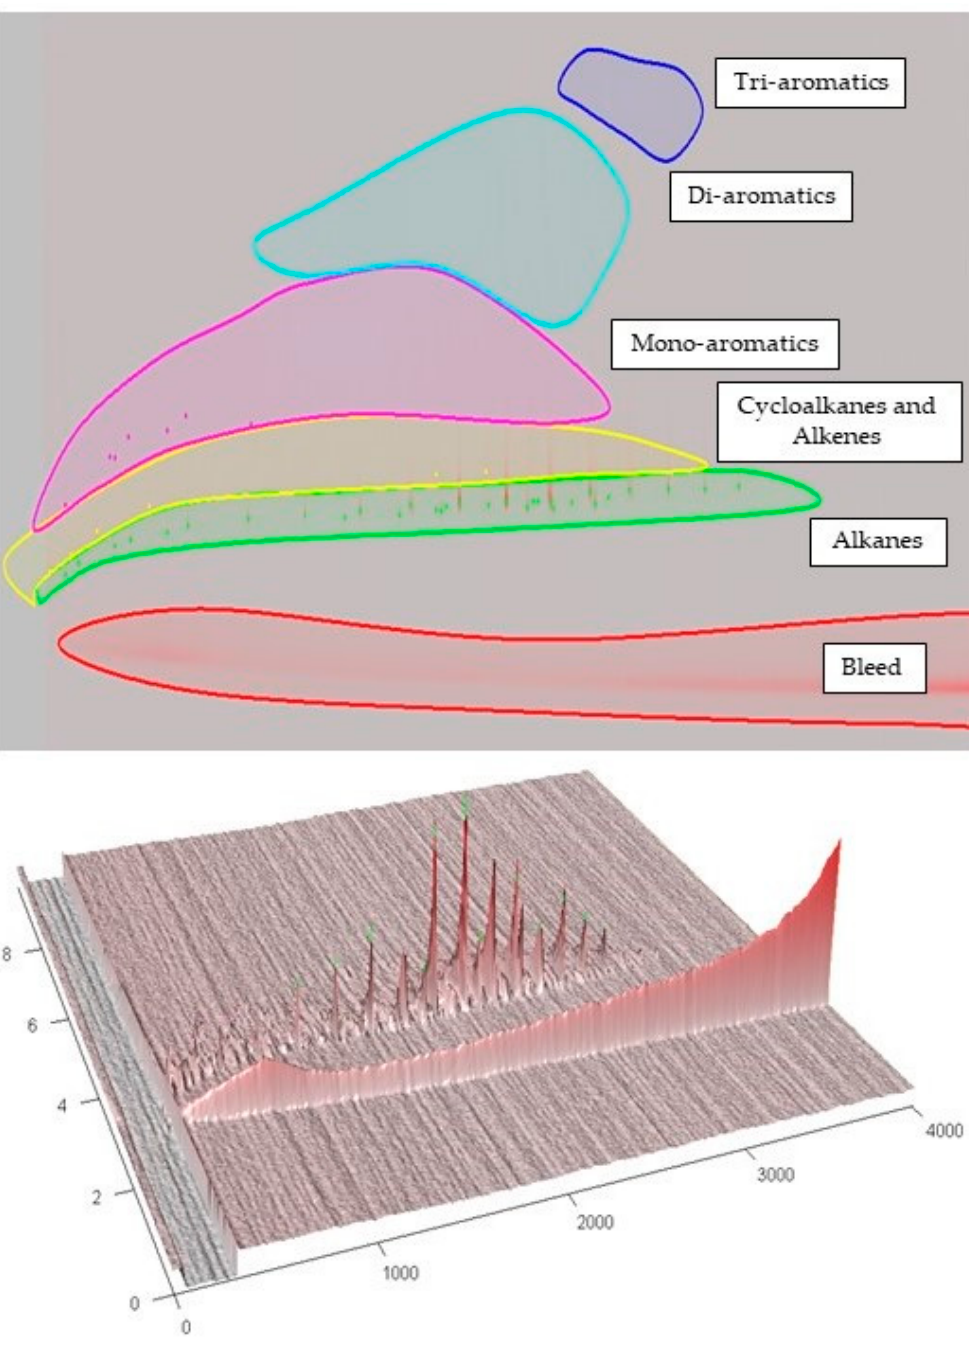
Figure 10. Average sample after the deactivation procedure type 2.